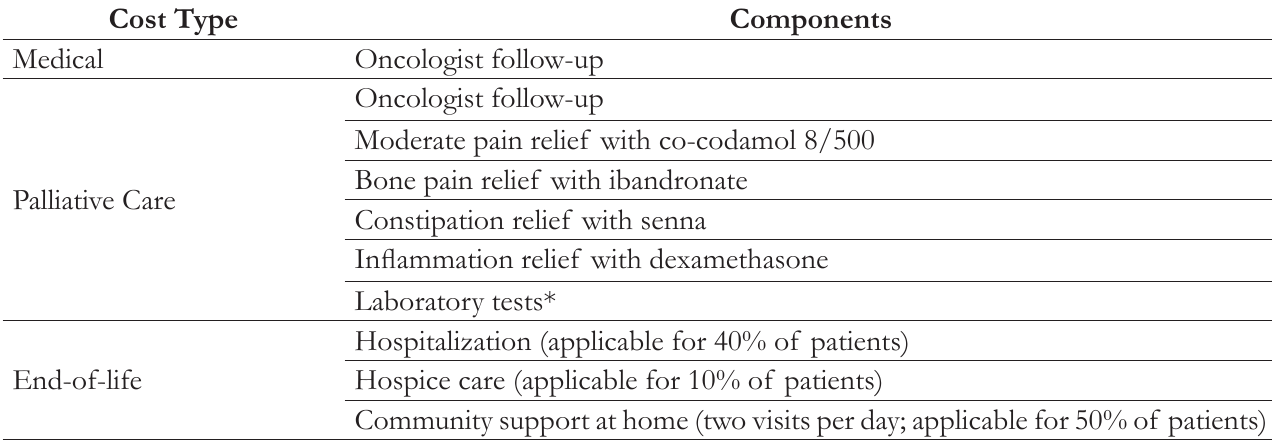
Table 3. Healthcare Utilization Costs per Patient per Month 20,21